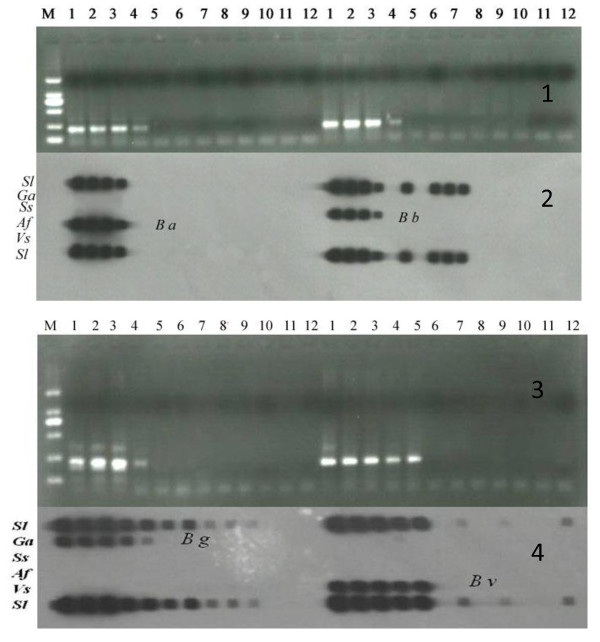
The sensitivity of the RLB assay for B. burgdorferi sensu lato. Plate 1 shows the sensitivity of the nested-PCR using Ba and Bb probes; Plate 2 shows the sensitivity of RLB using Ba and Bb probes; Plate 3 shows the sensitivity of the nest-PCR using Bg and Bv probes; Plate 4 shows the sensitivity of the RLB of using Bg and Bv probes. Lane1-12: 100-11 10 × fold dilution DNA of Genome for B.burgdorferi sensu lato Row 1-6: oligonucleotide probe of B. burgdorferi sensu lato (Sl); oligonucleotide probe of B. burgdorferi sensustricto; (Ss); oligonucleotide probe of B. garinii( Ga); oligonucleotide probe of B. afzelii (Af); oligonucleotide probe of B. valaisiana (Vs); oligonucleotide probe of B. burgdorferi sensu lato (Sl).